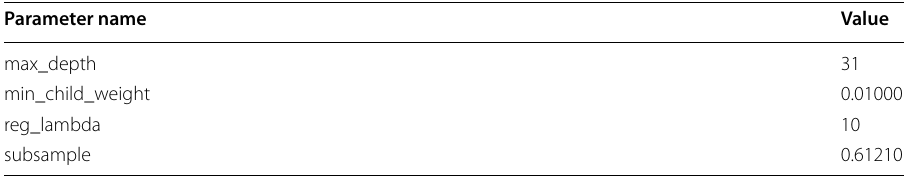
Table 95 Modes of XGBoost tuned hyperparameter values for experiments with the keylogging dataset